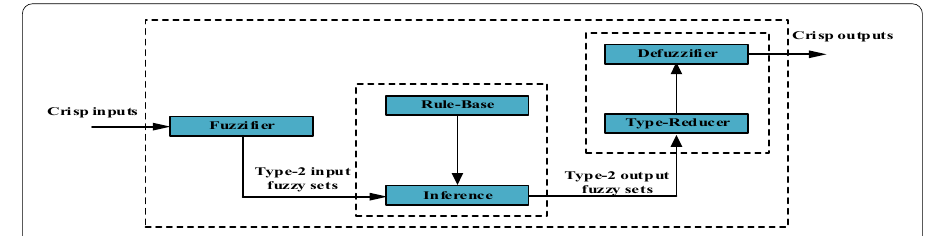
Fig. 3 The generic structure of Type‑2 fuzzy logic